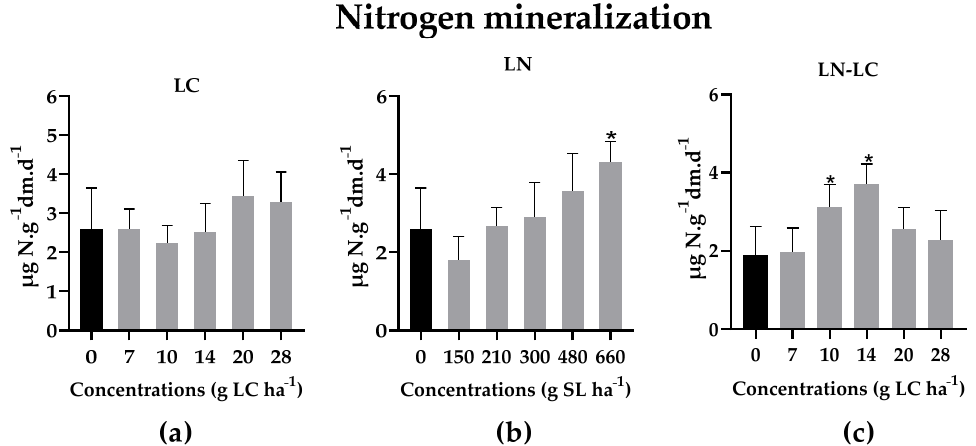
Figure 7. Nitrogen mineralization activity in soils exposed for 15 days to different concentrations of LC ( a ), LN ( b ), and LN–LC ( c ). The concentrations tested are based on the amount of LC. In the case of LN, the concentrations indicated are of solid lipid (SL) used in the synthesis of LN. The same concentrations of SL were tested for LN–LC. Results are represented by mean ± SD values. Asterisks mark the significant differences in relation to the control group (0 g LC ha − 1 ): ( c ) p < 0.05, Dunnett; ( a , b ) p < 0.05, Dunn’s.